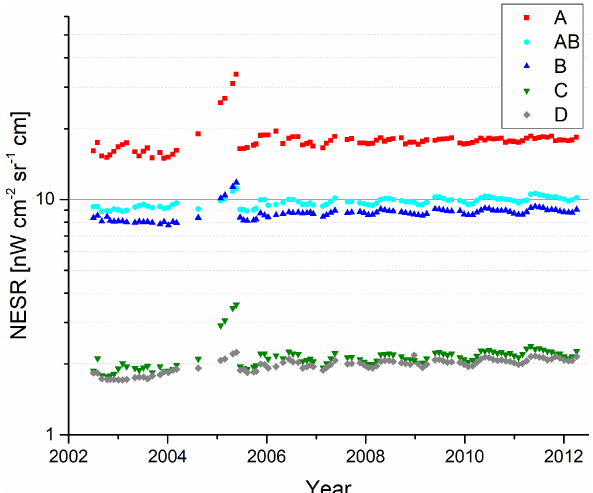
Figure 5. Relative gain error due to noise for FR and OR mode in percent. Please note the logarithmic